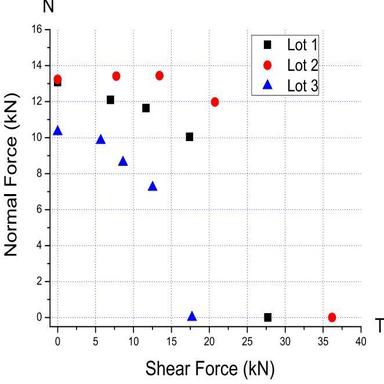
Effect of the nugget spot weld diameter on N-T diagram.